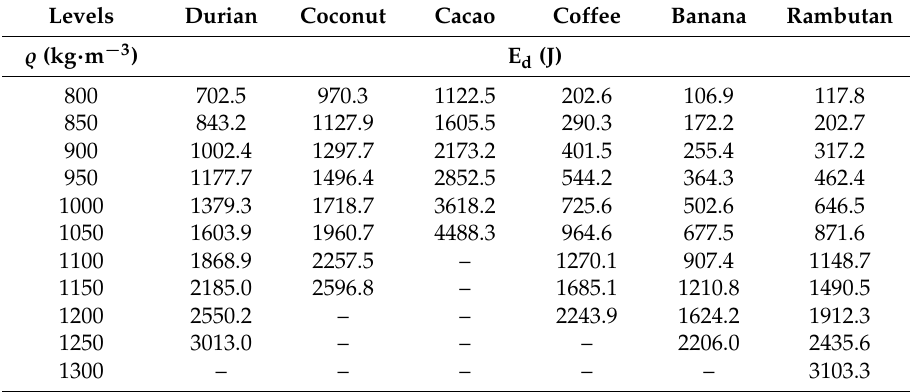
Table 10. Required deformation energy E d (J) consumed for specific bulk density (cid:36) (kg · m − 3 ). Levels Durian Coconut Cacao Coffee Banana Rambutan E d (J) 702.5 970.3 1122.5 202.6 106.9 117.8